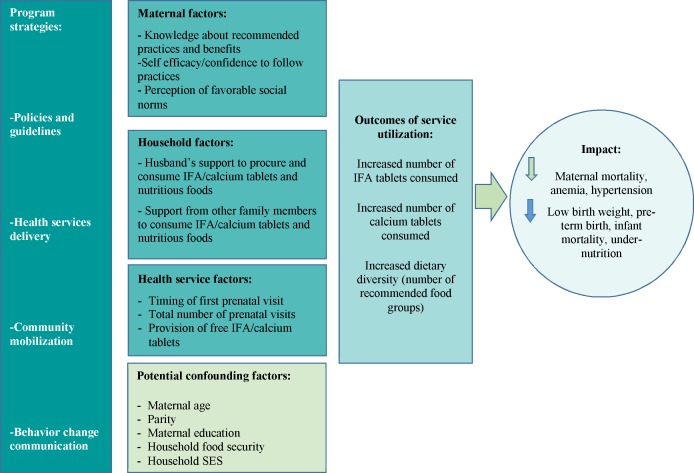
Conceptual framework of factors influencing maternal nutrition practices.